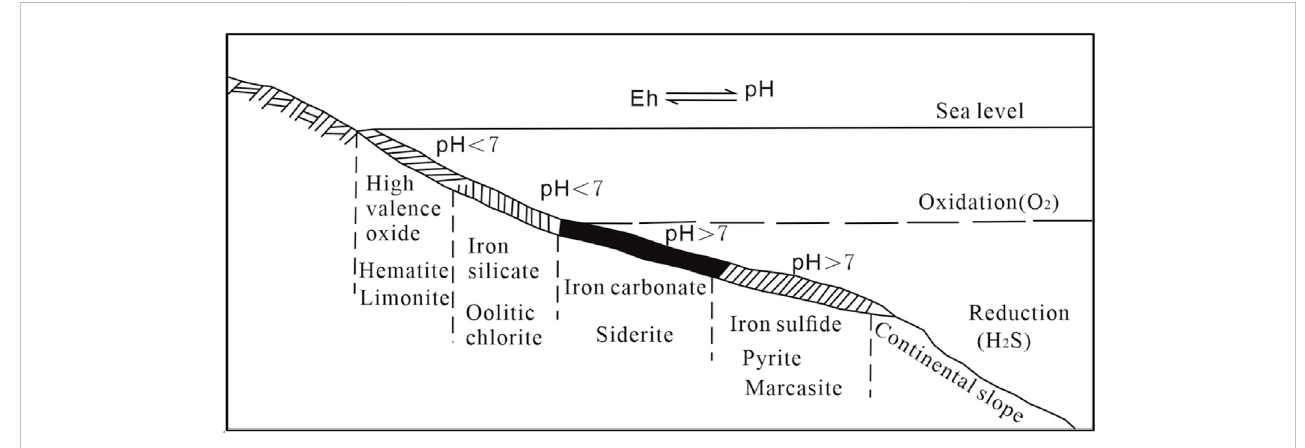
FIGURE 10 Schematic diagram of the facies change of sedimentary iron ore deposits (modi fi ed from Qiu,